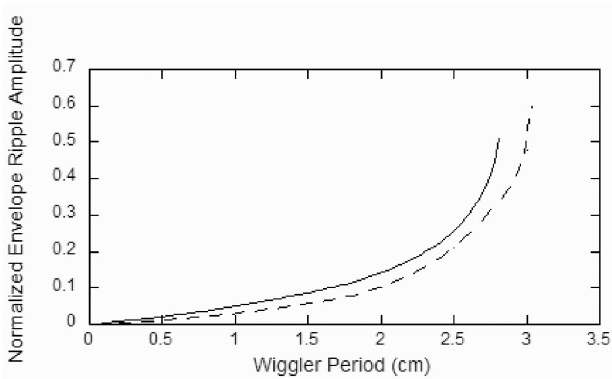
FIG. 9. Envelope ripple amplitude versus focusing period for wiggler focusing, for two-plane focusing (solid line) and for single-plane focusing (dashed line), both with vertical emittance and space-charge